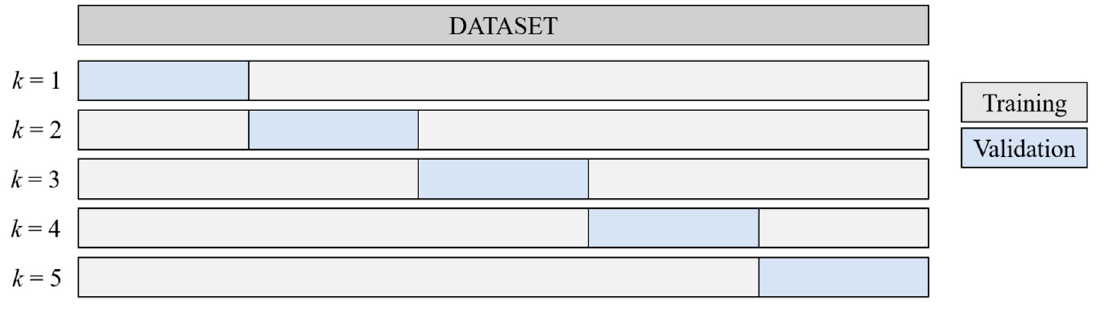
Figure 8. K-fold cross-validation. Figure 8. K ‐ fold cross ‐ validation.